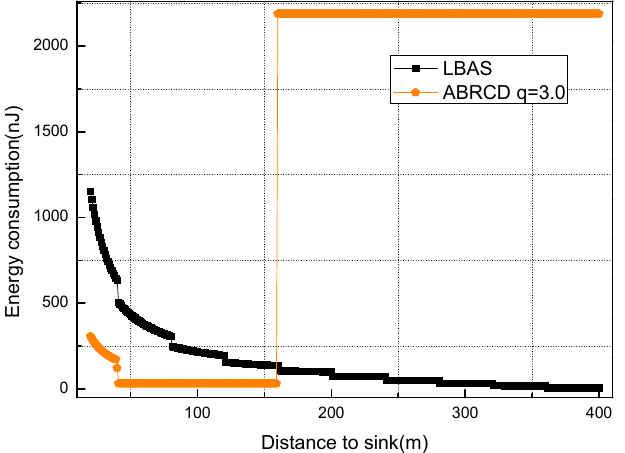
Figure 22. Energy consumption of nodes 20~400 m away from sink with q = 2.5. Sensors 2018 , 18 , x FOR PEER REVIEW